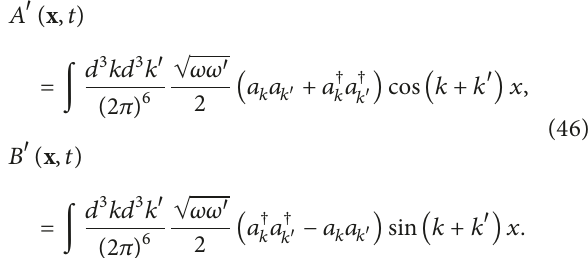
The maximal values of the two results derived by different methods are slightly different. In fact, this is not hard